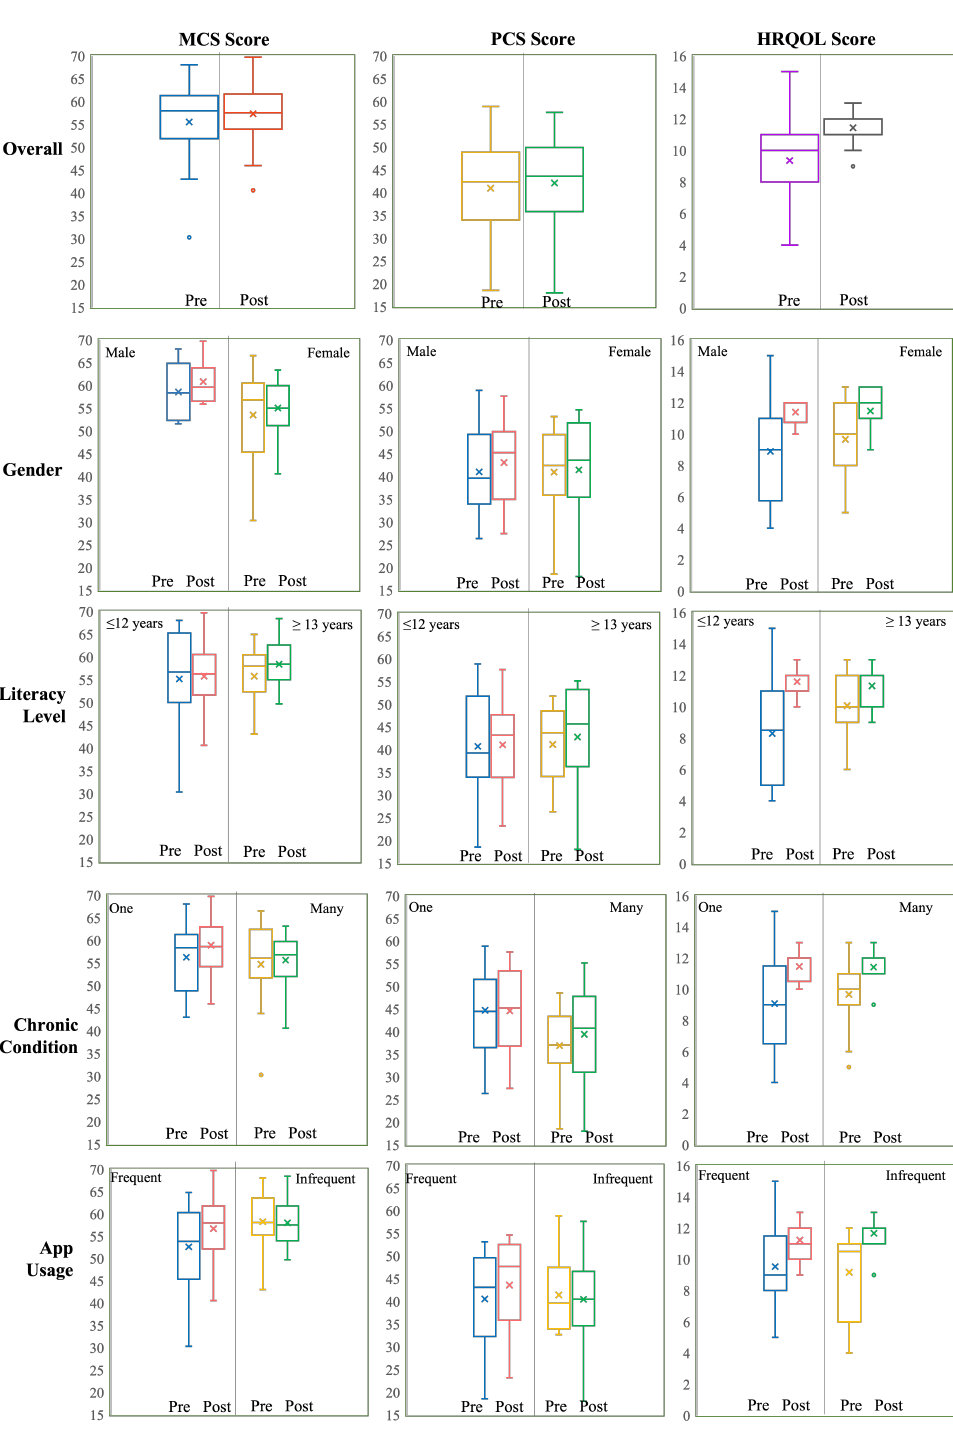
Figure 4. Pre and Post MCS, PCS and HRQoL score distribution according to various demographics. (x within the box is the mean and line is the